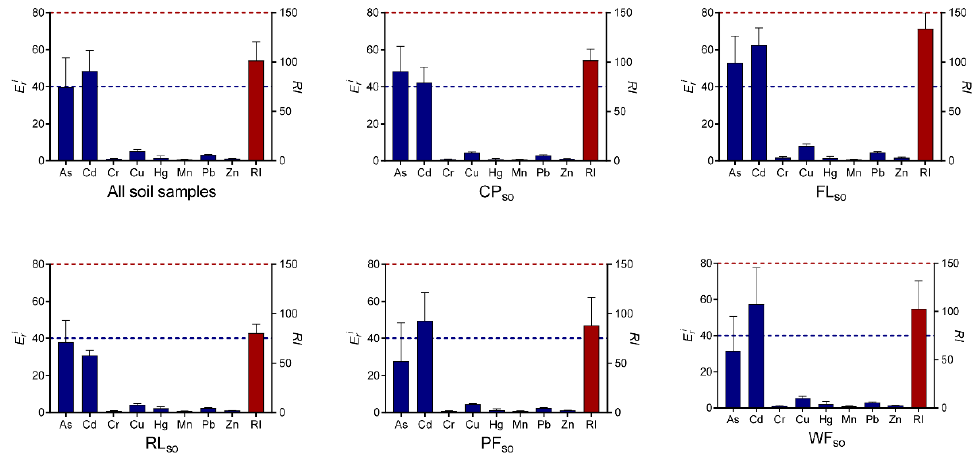
Figure 4. The potential ecological risk index ( RI , E ri ) of metals in the surface soil samples that were associated with five types of land use (CP, FL, RL, PF, and WF). The blue bar-plot on the left Y-axis represents the mean E ri values of the 10 or 50 replicate samples per metal, and the blue dashed line indicates E ri = 40. The red bar-plot on the right Y-axis represents the mean RI value of the 10 or 50 replicate samples, and the red dashed line indicates RI = 150.